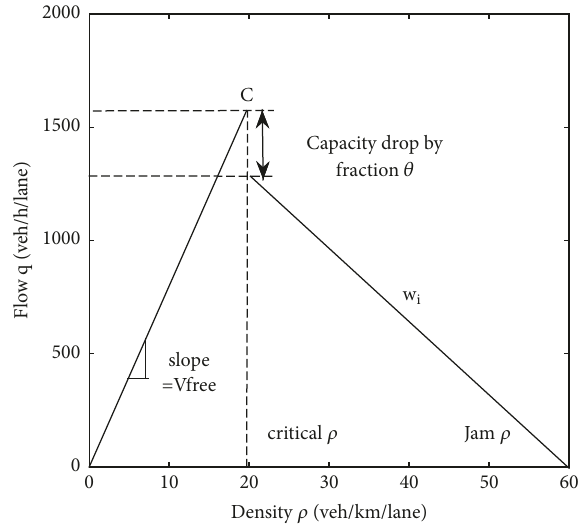
Figure 2: The triangular FD